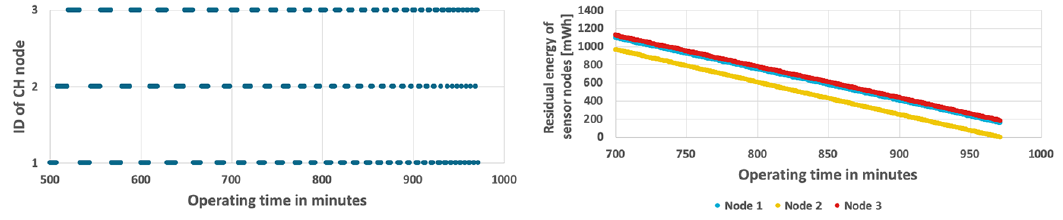
Figure 10. Energy consumption by sensor nodes for EDCR algorithm with a variable number of detected events.